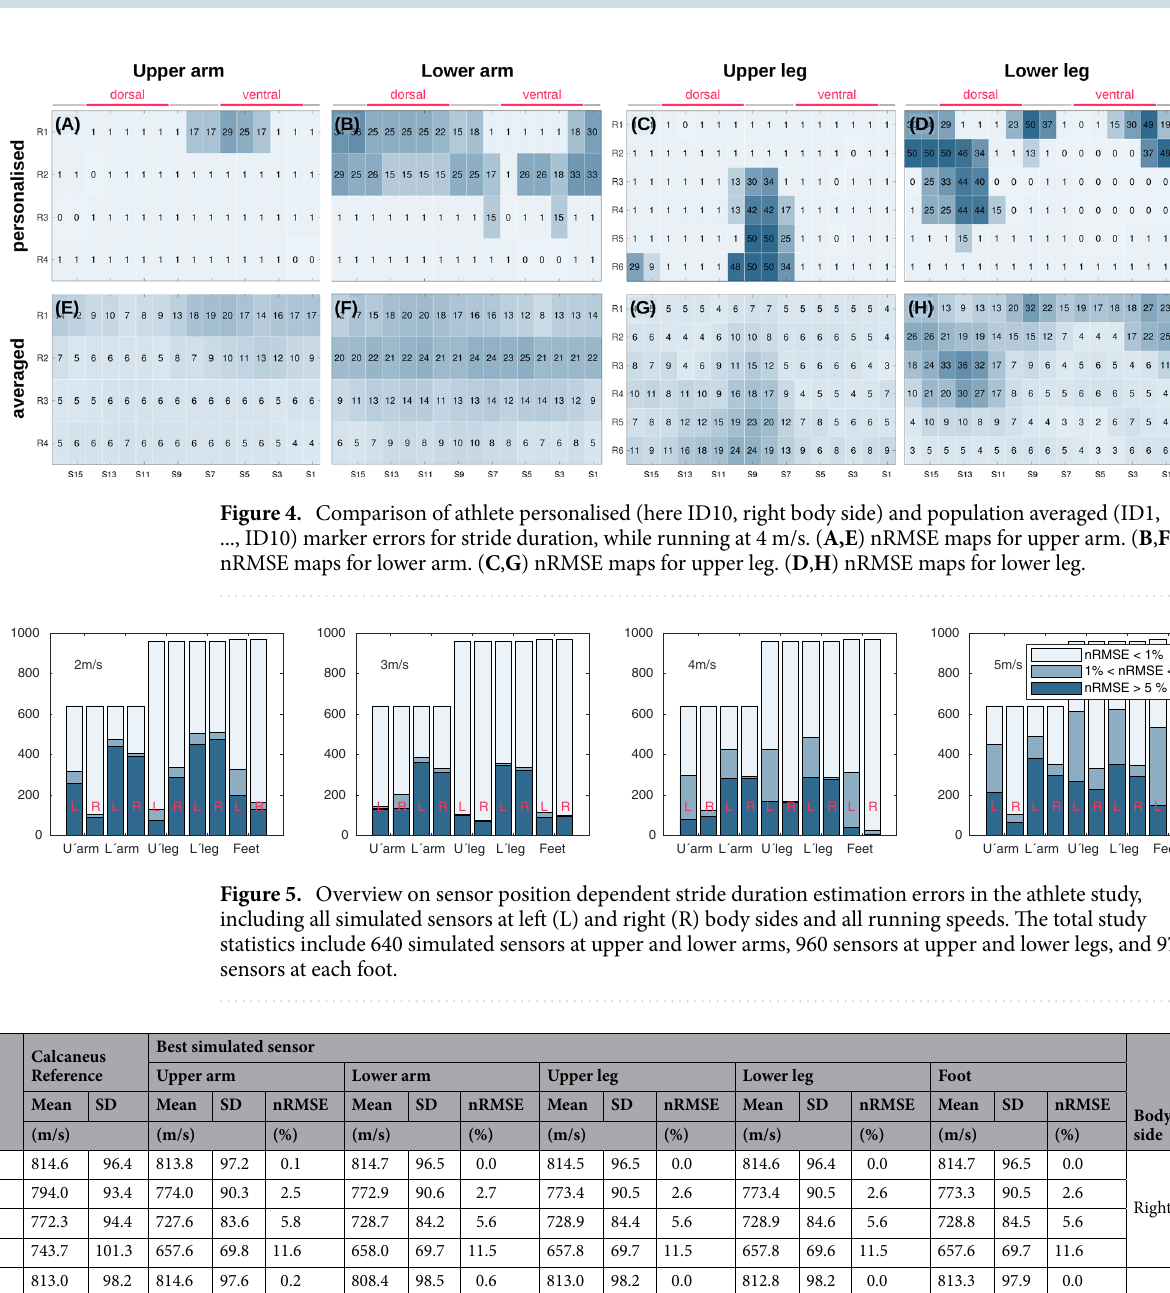
Table 1. Stride duration reference and best personal sensor position per body part across all athletes derived with the cmplx algorithm. Mean, std. dev. (SD), and relative error (nRMSE) between best personal simulated sensor position and the calcaneus reference are shown for each running speed. With speed, errors increase, but personal sensor positioning can limit relative error to below